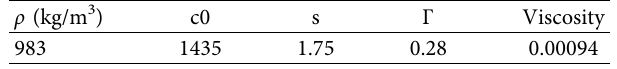
Table 3: Water model and state equation parameters.